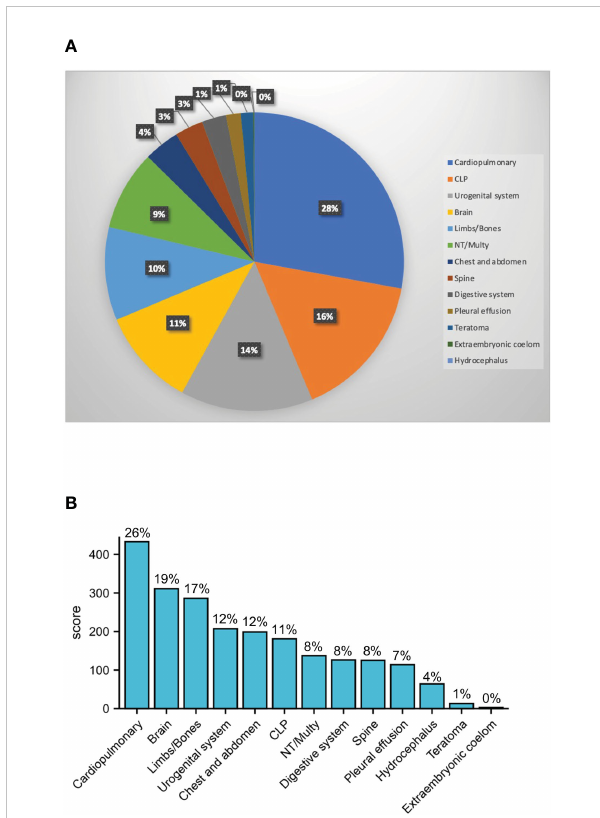
FIGURE 1 Sex ratio of 13 types of structural malformations. (A) Pie chart for the ratio of 13 types 1007 solitary malformations; (B) case number of 13 types of all 1632 structural malformation, the percentage shows malformations that contains such deformities (cardiopulmonary: cardiopulmonary dysplasia; CLP: cleft lip and palate; NT: nuchal translucency; Multy: abnormalities with or without other deformities; Brain: brain-related malformations and arachnoid cysts; urogenital system: urinary or reproductive system malformations; chest and abdomen: diaphragmatic hernia, omphalocele, gastroschisis; limbs/ bones: limbs, bones, hands, and feet abnormalities; spine: spine and vertebral body related deformities; digestive system: digestive system